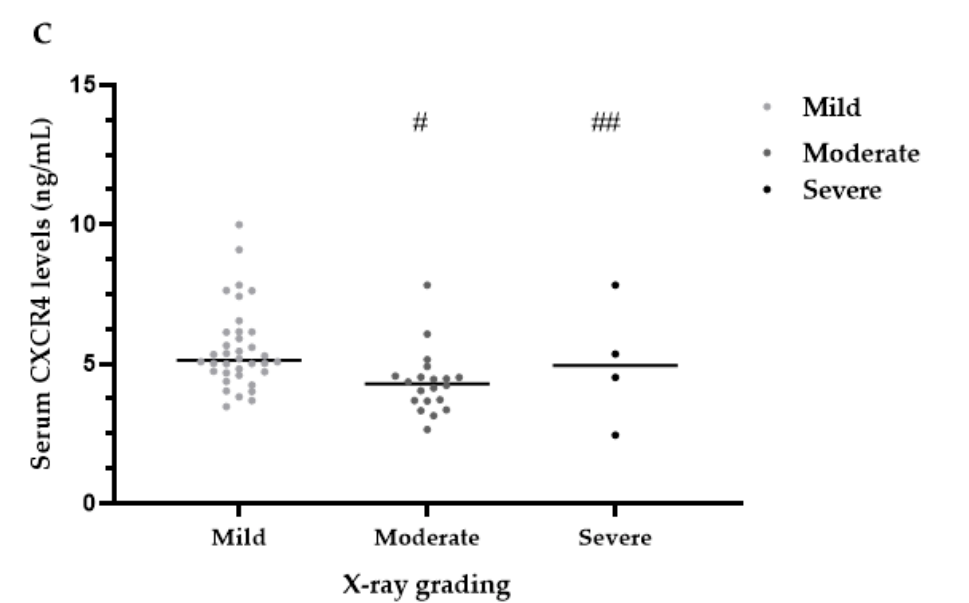
Figure 4. ( a ) Analysis of serum CXCR4 levels in the SF and control groups; ( b ) Analysis of CXCR4 levels in the SF group by sex and age; ( c ) Analysis of CXCR4 levels in the SF group by X-ray diagnostic grade. ** p < 0.001 compared to the control group. * p < 0.05 compared to ~60. ## p < 0.05 compared to both mild and moderate. # p < 0.001 compared to mild. CXCR4: C-X-C motif chemokine receptor 4.